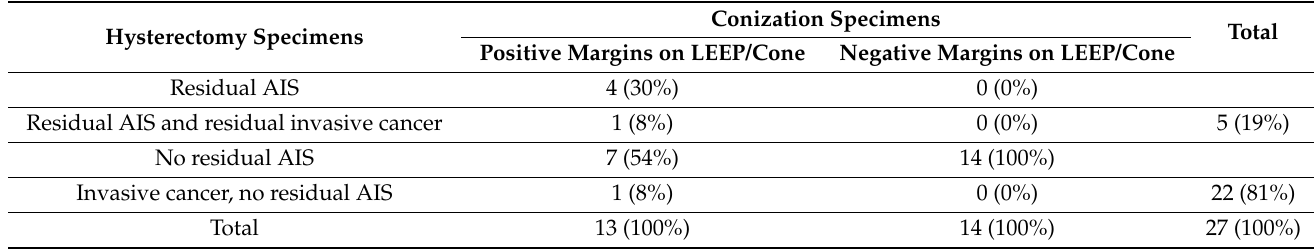
Table 2. Specimen margin status upon cervical conization as correlated with findings of residual disease on post-conization hysterectomy